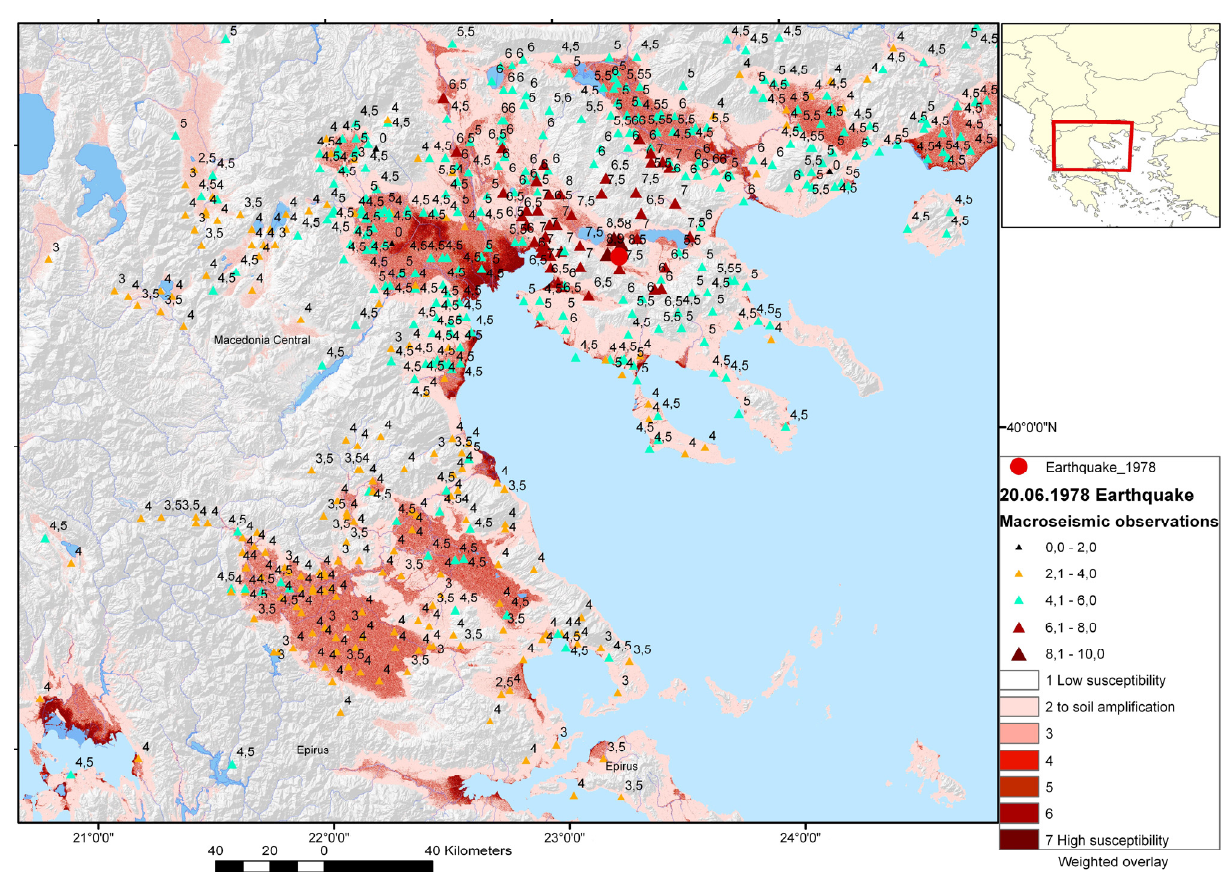
Figure 5. Overlay of the weighted overlay-calculations (SRTM DEM data) with macroseismic intensity (MMI) observations of the Aristotle University of Thessaloniki (AUTH), Thessaloniki macroseismic database